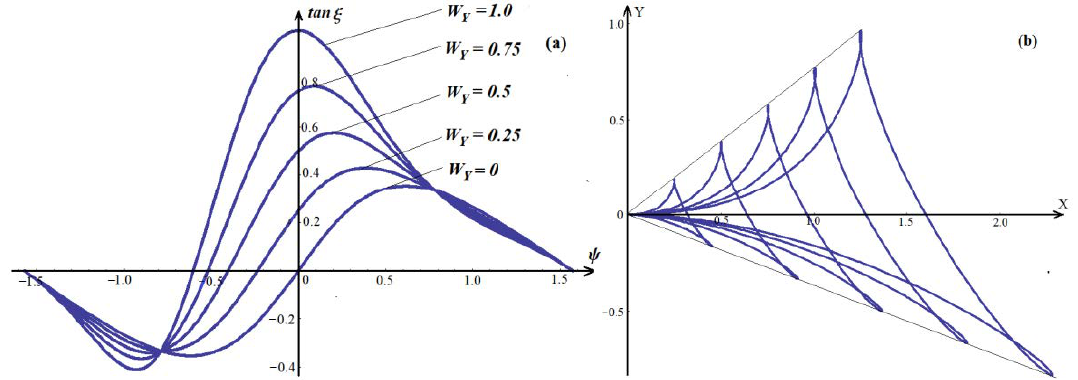
Figure 5. Cross interaction of waves and shear current: ( a ) Directions of ship waves − k Y / k X = tan ( ψ ) depending on the ray angle ξ for different values W Y > 0; ( b ) Phase lines θ ( X , Y ) = const for the current shear value ( W Y =